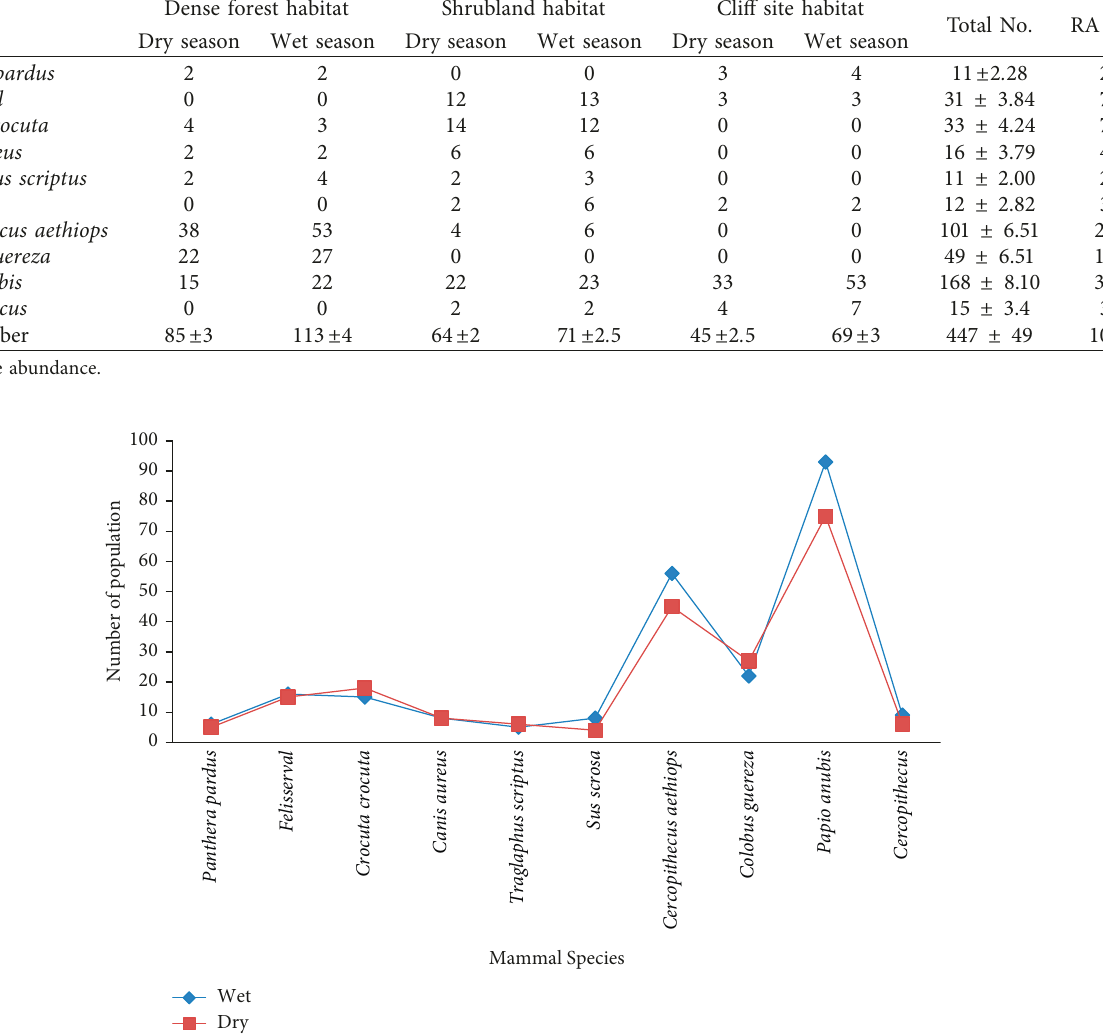
Figure 4: Seasonal variation in species composition and abundance of large and medium wild mammals in Tiski Waterfall, Ethiopia.